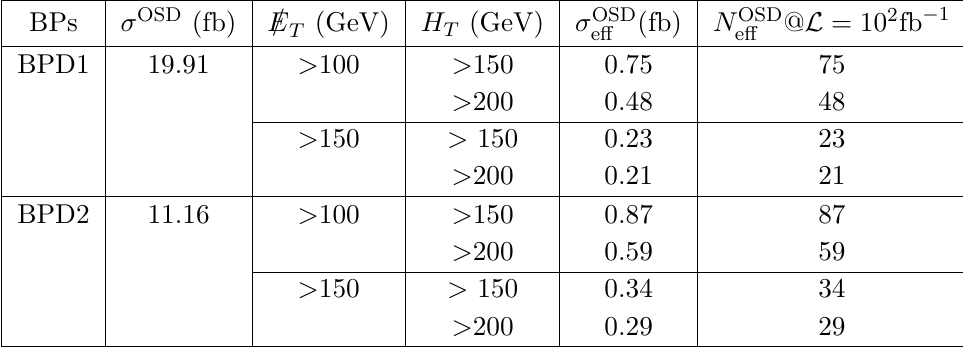
Table 7 . Signal cross-section for BPD1-BPD2 after the selection cuts are